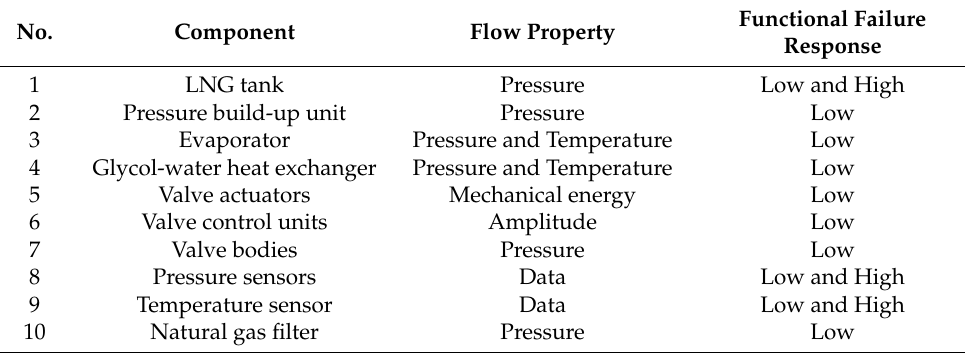
Table 6. Functional failures injection affecting the supply of natural gas.